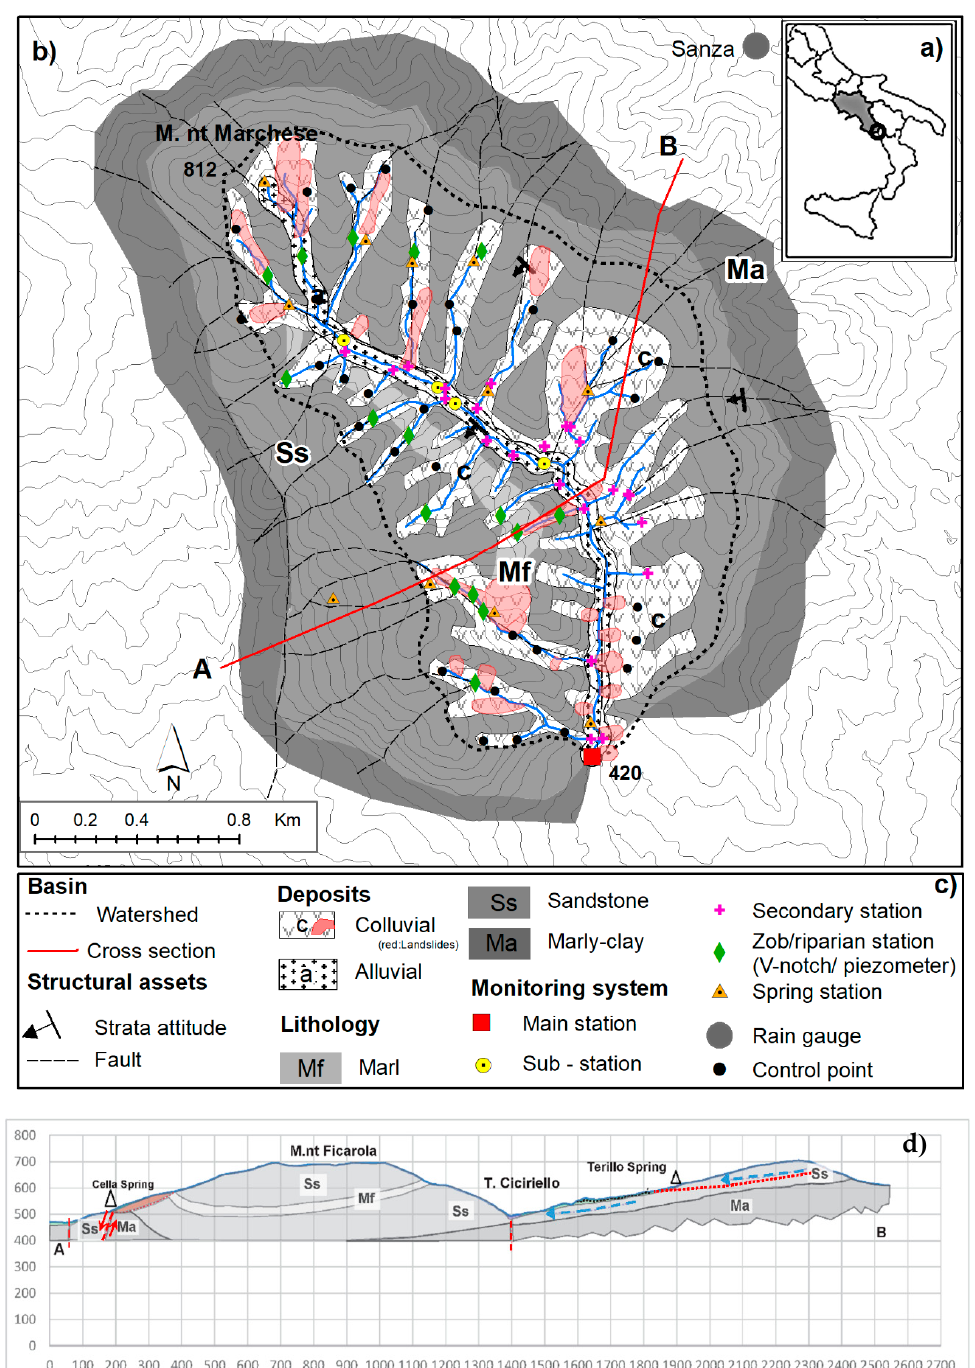
Figure 2. Ciciriello Mediterranean experimental catchment (modified from [4]). ( a ) Upper right inset: geographical location of the Bussento river basin; ( b ) left inset: schematic geological map, hydro-structural features and location of the monitoring stations; ( c ) lower inset: A–B: geological cross-section trace. Bedrock lithology; Ma: Tertiary marly–clayey and argillite (Upper Saraceno formation—North Calabrian Unit), base aquiclude; Ss: sandstone (Albidona–San Mauro formation—Cilento Group), fractured and weathered local aquifer; Mf: Miocene marly–limestone (Fogliarina marls member), interlayered and confined fractured local aquifer; ( d ) geological cross section: see (c) above for geological legend; Small triangle: main spring; dashed blue arrows: groundwater